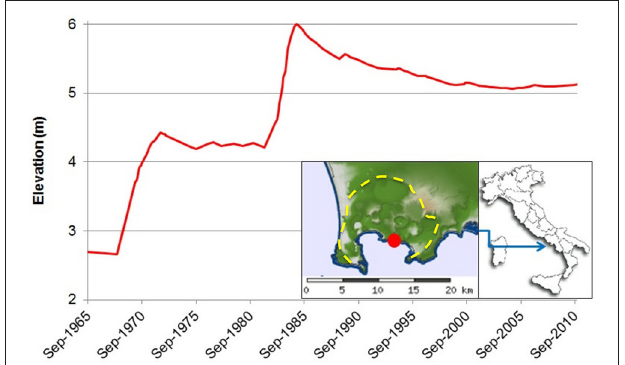
FIGURE 1 | Uplift and subsidence at Campi Flegrei caldera (yellow dashed line in the inset) between 1965 and 2010, recorded at the benchmark 25 (red dot) of the leveling network of Campi Flegrei (modified after Del Gaudio et al., 2010). The main uplift episodes occurred in 1968-1972 and 1982–1985 periods. These two non-eruptive unrest led to the evacuation of the town of Pozzuoli.